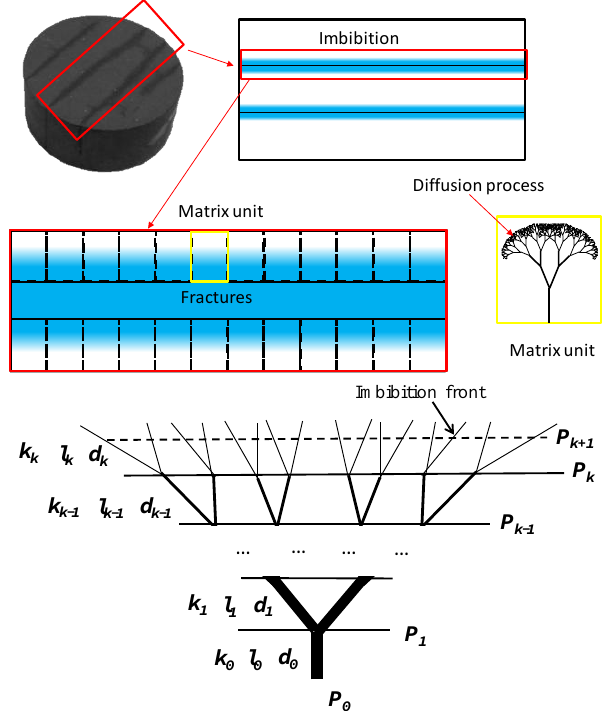
Figure 2. Schematic of the equivalent model of the fractal network